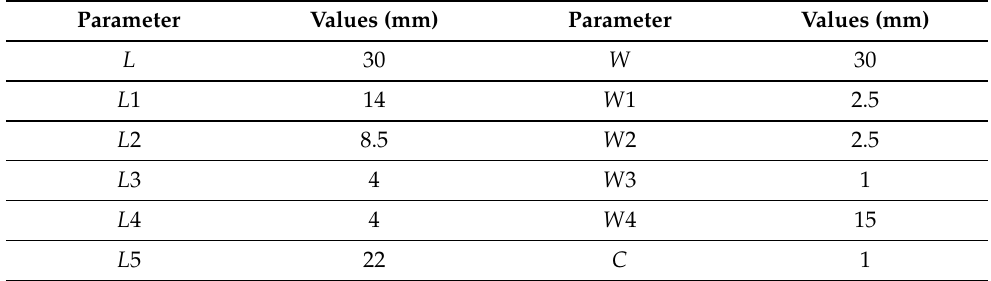
Figure 1. Geometry of the proposed 1 × 3 MIMO antenna: ( a ) Top view of three radiating elements, each loaded with two notching elements; ( b ) L u and U u shape as notching elements to suppress WiMax and WLAN, respectively; ( c ) Back view of antenna in a kite shape along with two semicircle loading to achieve batter matching. Table 1. Optimized dimensional values of different parameters of the proposed UWB-MIMO antenna system with a three notch band using only two notching